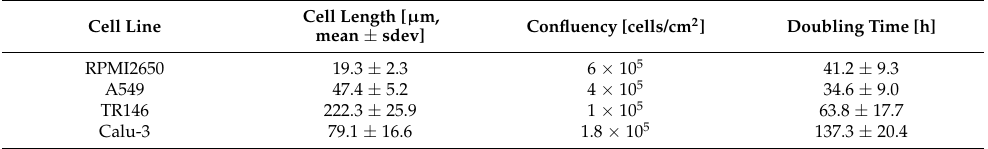
Table 1. Summary of fundamental characteristics of the four mucosa cell lines including cell length, cell density of a confluent monolayer as well as mean doubling